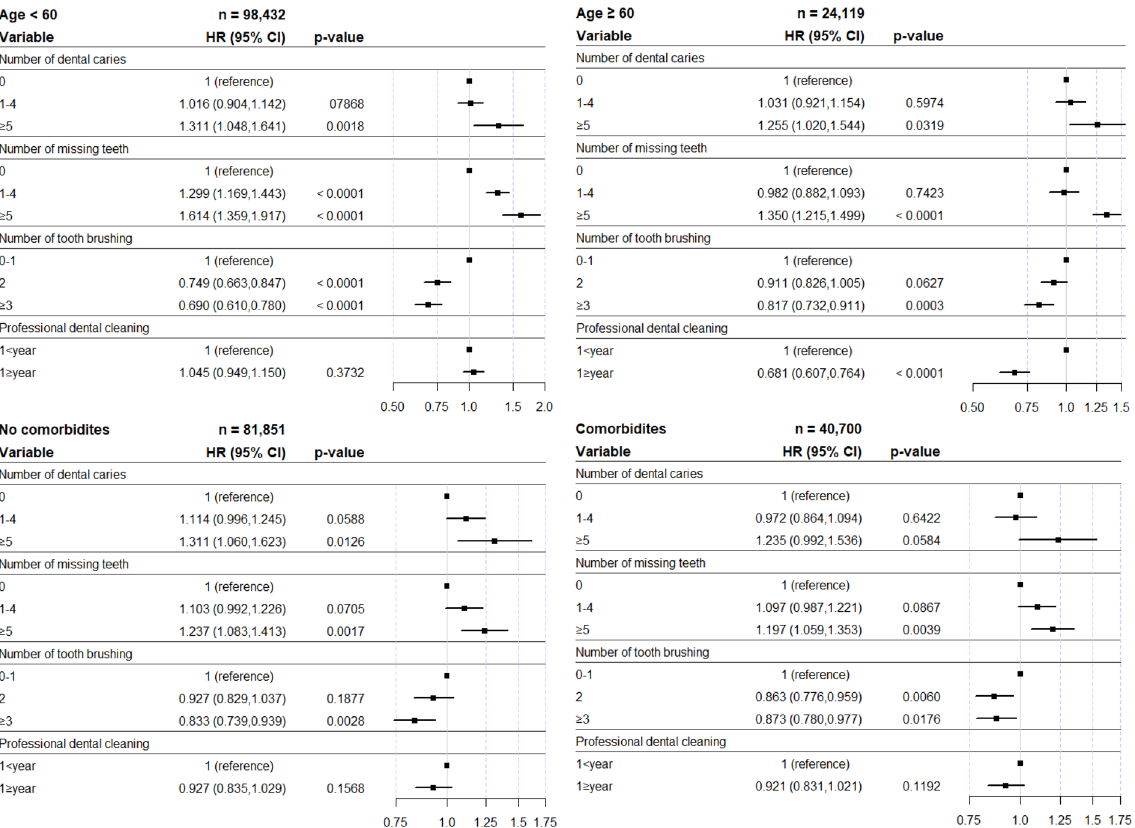
Figure 4. Hazard ratio and 95% confidence interval for incidence of pneumonia in subgroup analysis according to oral health status and oral hygiene behaviors. HR, hazard ratio; CI, confidence